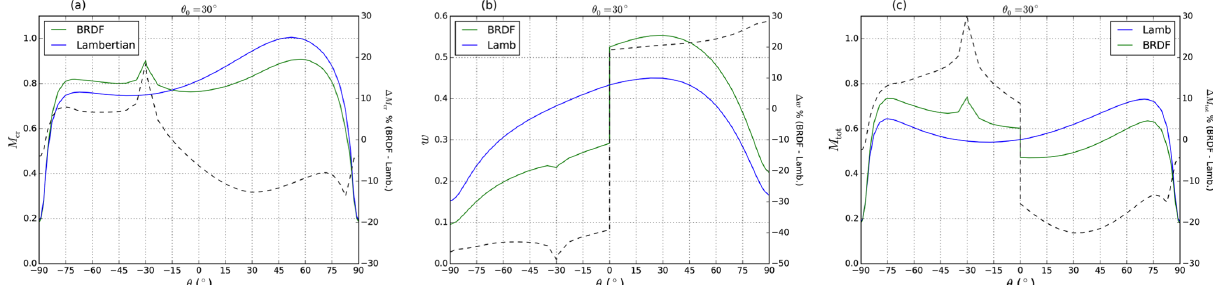
Figure 9. (a) Clear-sky tropospheric NO 2 AMF, (b) cloud radiance fraction, and (c) total tropospheric NO 2 AMF computed with surface BRDF (green) and with a Lambertian surface (blue) and their relative difference (right axis) as a function of viewing zenith angle in the principal plane ( ϕ − ϕ 0 = 180 ◦ for negative θ and ϕ − ϕ 0 = 0 ◦ for positive θ ), for θ 0 = 30 ◦ . P cd = 850hPa, Lambertian c eff = 0 . 1 and BRDF c eff = 0 . 10 ± 0 . 05. Surface BRDF parameters are ( f iso , f vol , f geo ) = ( 0 . 04 , 0 . 03 , 0 . 008 ) and A ws = 0 . 036 for the Lambertian surface.